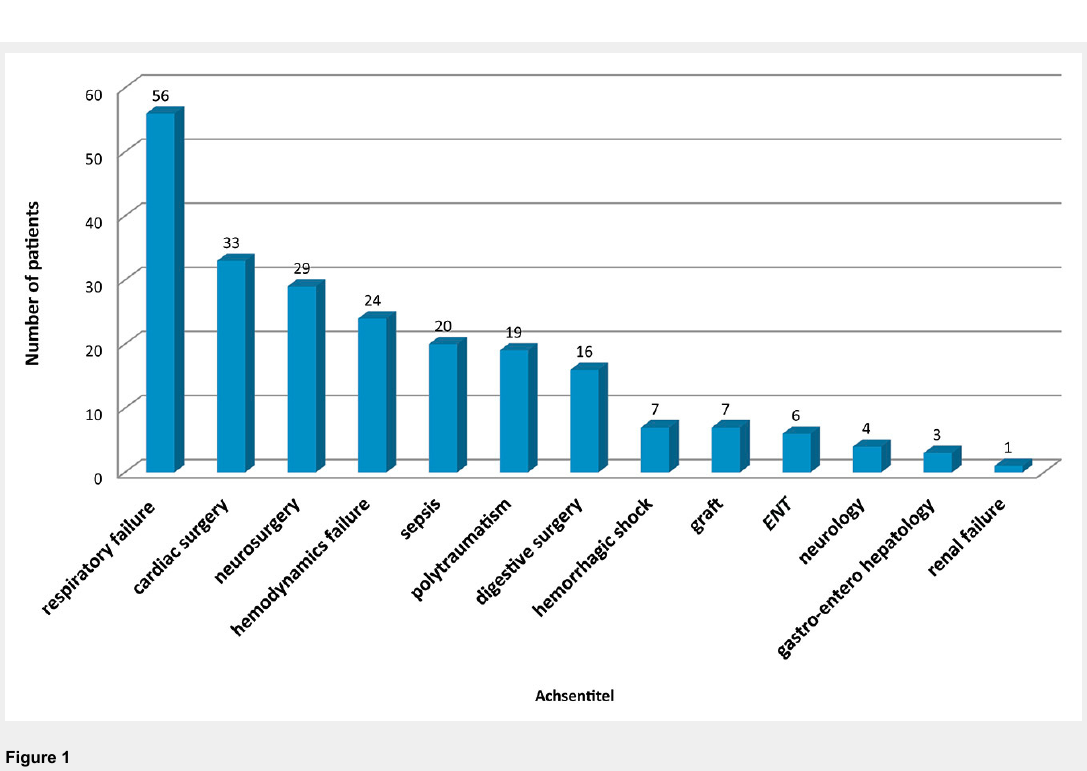
Diseases that commonly led to prolonged ICU stays in 2015. ENT = ear nose